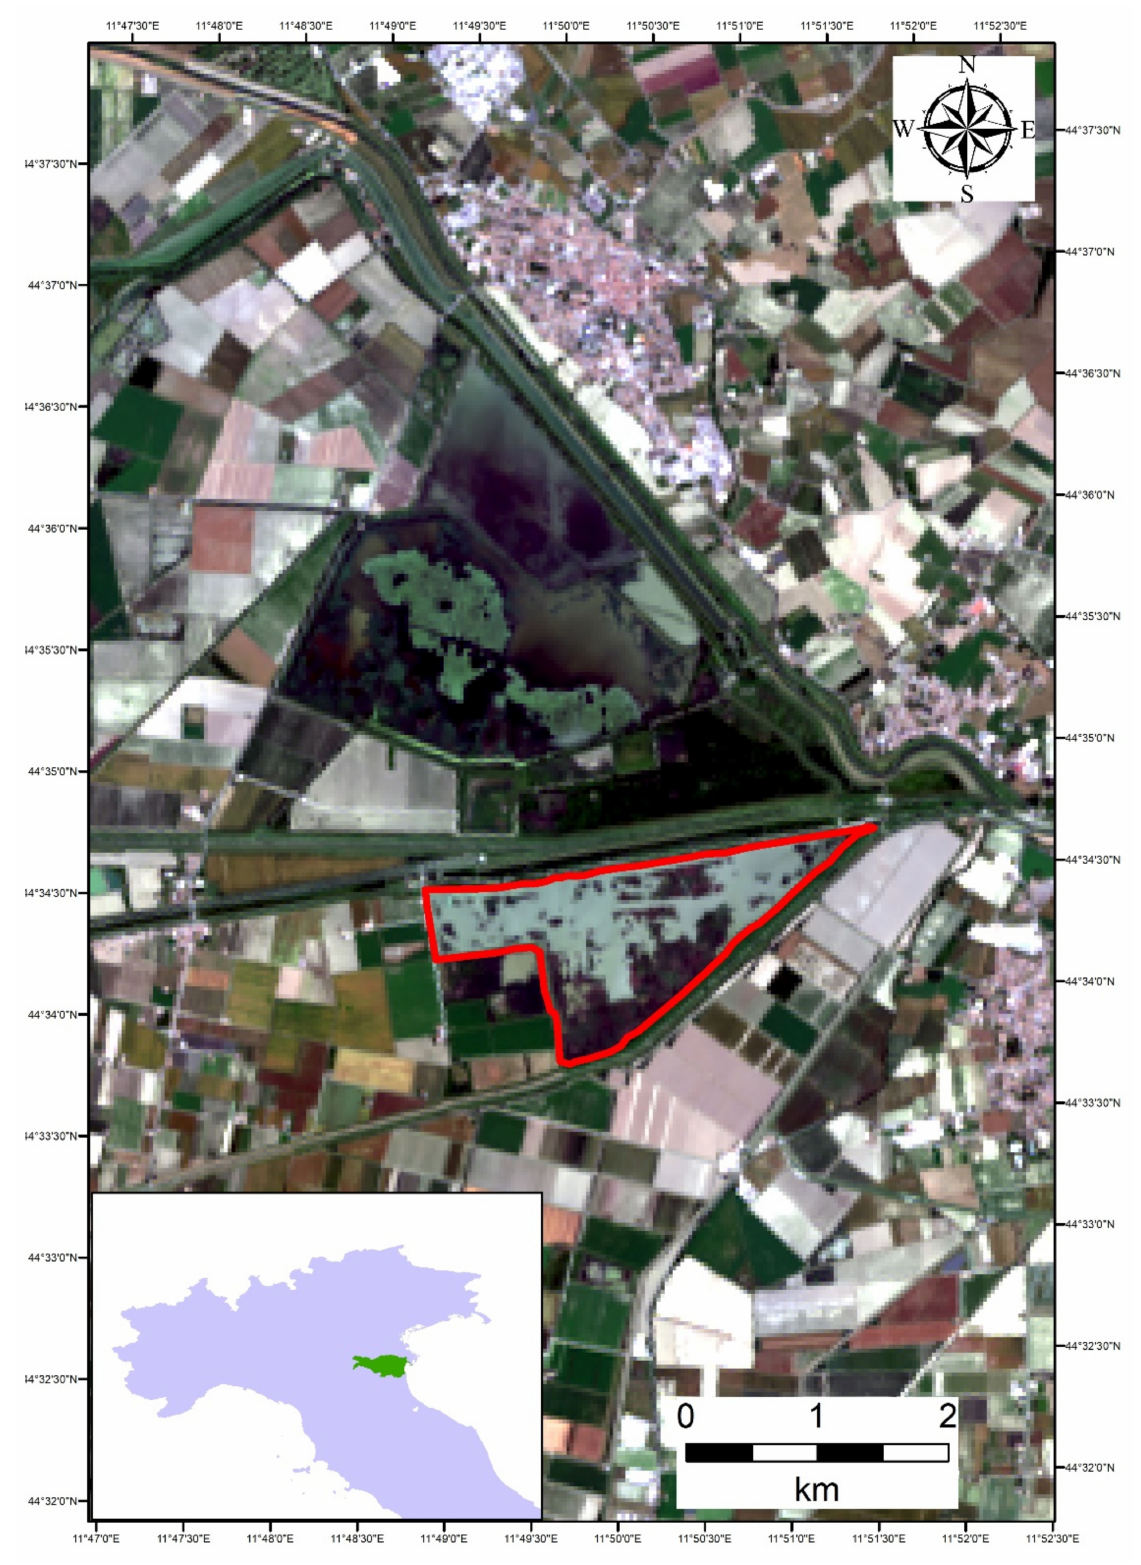
Figure 1. Valle Santa wetland (highlighted in red) and Ferrara province in Italy (in the left back panel). Abiotic conditions were measured by means of water descriptors at each sampling date to test possible effects due to vegetation presence: NH 4+ , NO 2 − , NO 3 − , PO 43 − , sus- pended sediments (total, inorganic and organic fractions), O 2 , pH and temperature.